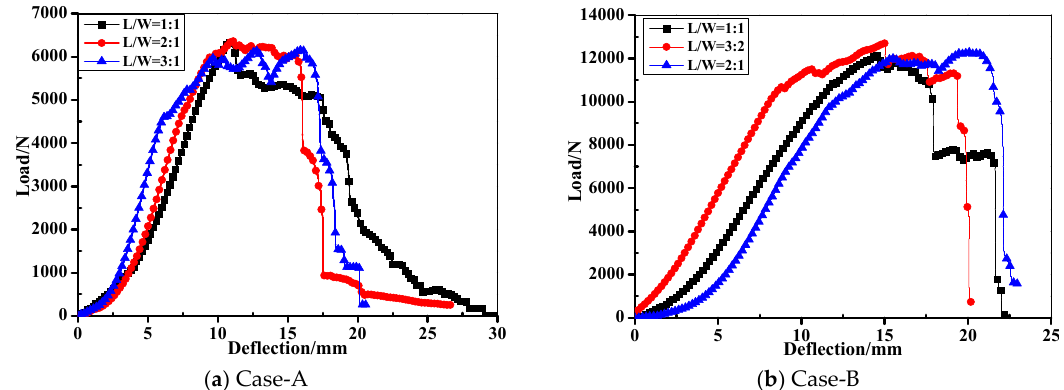
Figure 7. Typical load-deflection curves of the composite bolted joints in tensile test.